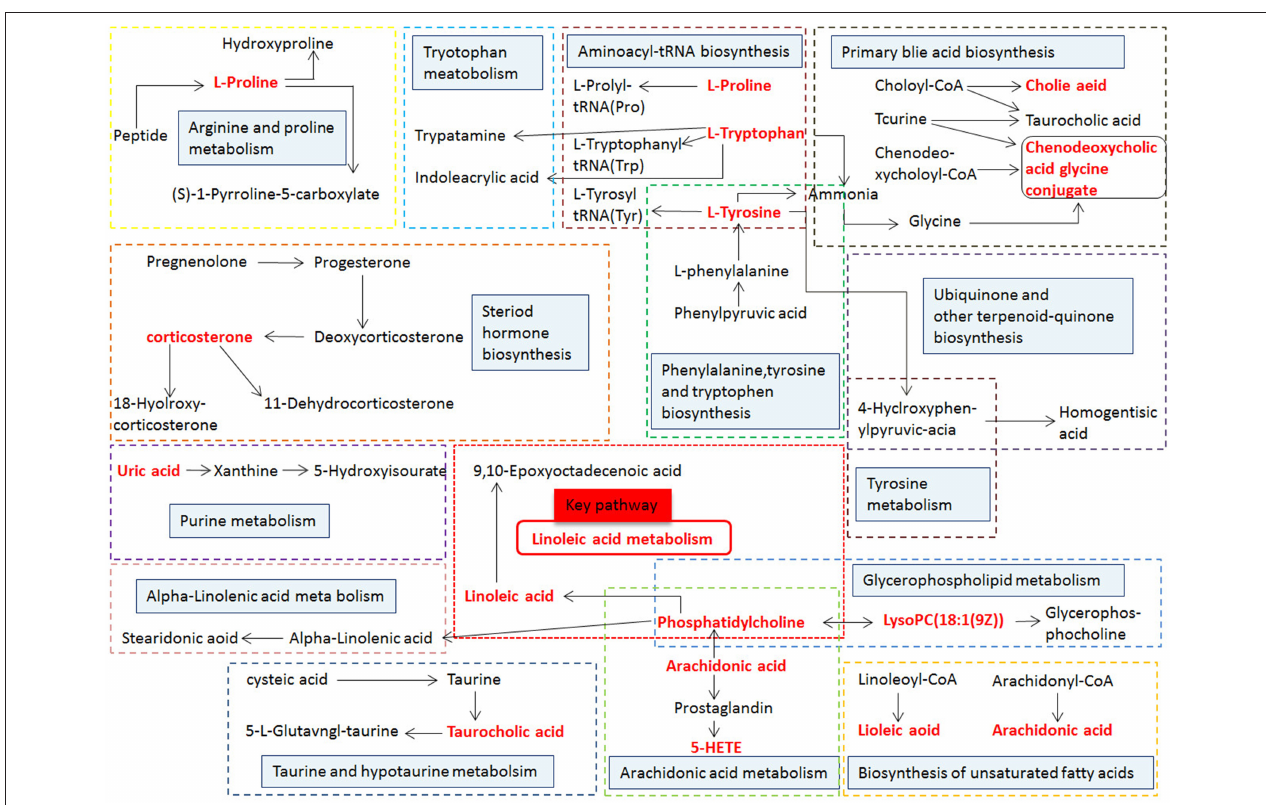
FIGURE 13 | Correlation networks of the potential biomarkers based on the KEGG. The red font represents the biomarkers detected in this experiment and blue filled boxes represent related metabolic